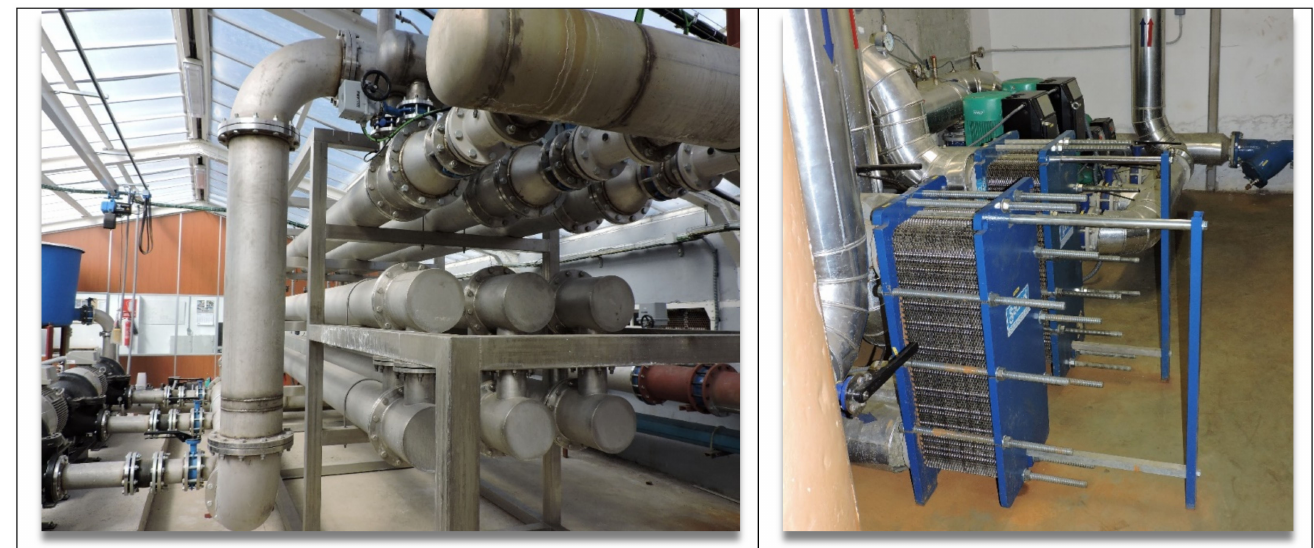
Figure 5. ( left ) Shell-and-tube heat exchangers between minewater and secondary circuit to hospital, Barredo shaft-top building; ( right ) minewater to secondary circuit plate heat exchangers. University plant room. Reprinted with permission from ref. [82]. Copyright 2015 David